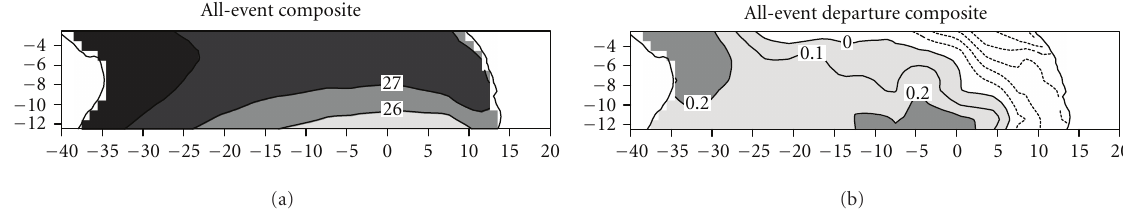
Figure 13: Latitude-longitude composite values (a) and composite anomalies (b) of SST ( ◦ C) averaged during the periods of the twelve selected events from the onset of EWs until the day (or first day) of strong-rainfall anomaly episodes over ENEB. Positive values are